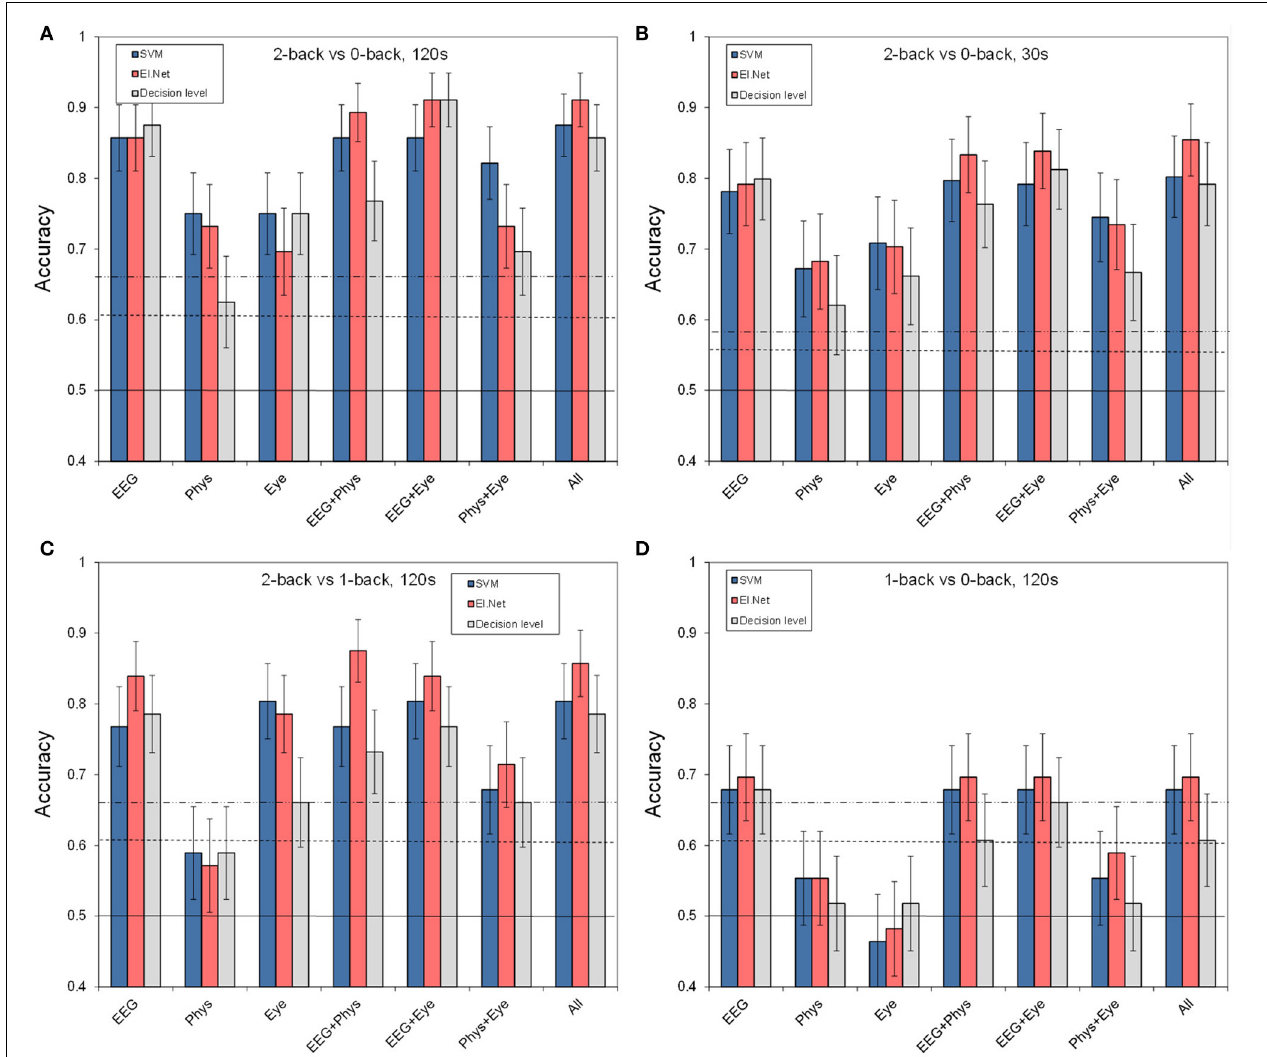
FIGURE 3 | Classification performance for separate and combined sensor groups for SVM, elastic net and a model that combines the outputs from different single feature models (“decision level”). (A) performance in